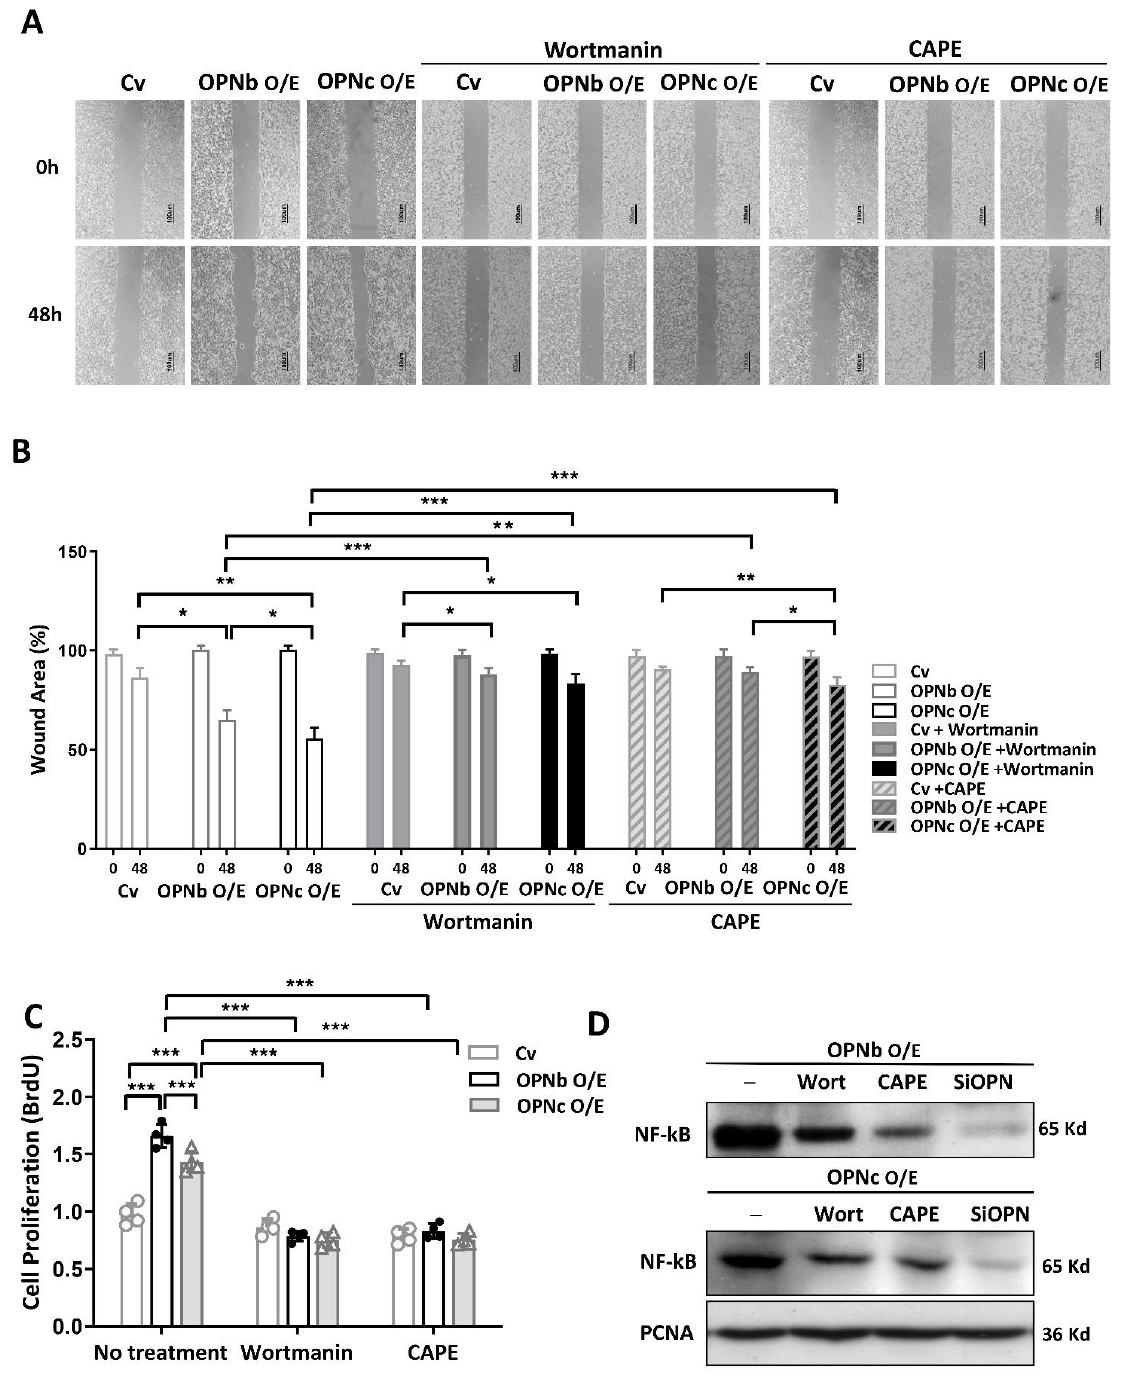
Figure 8. The effect of OPN variants on HEC1A cell migration via the PI3K or NF- κB signaling pathway. ( A , B ) A scratch wound assay was performed to investigate endometriotic cell migration. OPN isoforms can lead to cell migration, but treatment with 10 μM wortmannin ( PI-3K inhibitor) or 10 μM CAPE (NF - κB inhibitor) for 24 h can slow down or suppress cell migration. ( C ) Wortman- nin and CAPE inhibited proliferation in cells overexpressing OPN isoforms. ( D ) Nuclear transloca- tion of NF- κB was inhibited by OPN suppression. Plots represent the mean ± SEM, n = 4. ( * ) indicates a significant difference with p < 0.05. ( ** ) indicates a significant difference with p < 0.01. ( *** ) indicates a significant difference with p < 0.001.